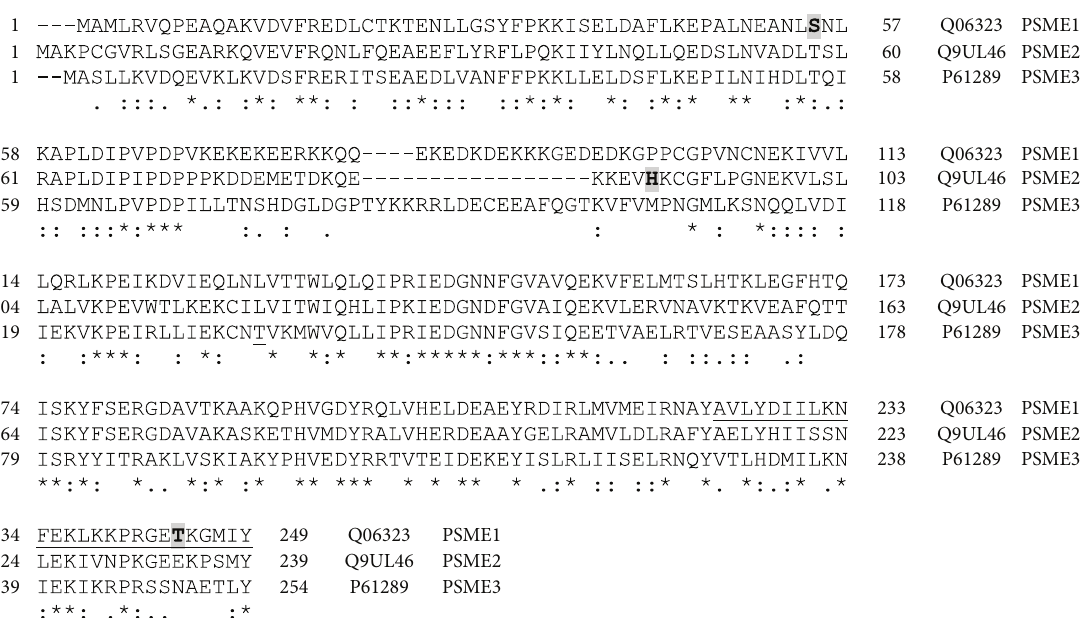
Figure 12: Alignment of human PSME subunits 1–3. Protein sequences of the three proteasome PSME subunits were aligned using Clustal W. ⋆ , identical residue in all six subunits; :, conserved amino acids with strongly similar properties; ., conservation between residues of weakly similar properties. Naturally occurring variants are highlighted with grey boxes. Alternatively spliced regions are underlined. Amino acid residue numbers are shown on the left and right of each sequence and the UniProt accession number and gene name of each sequence are shown to the right of each